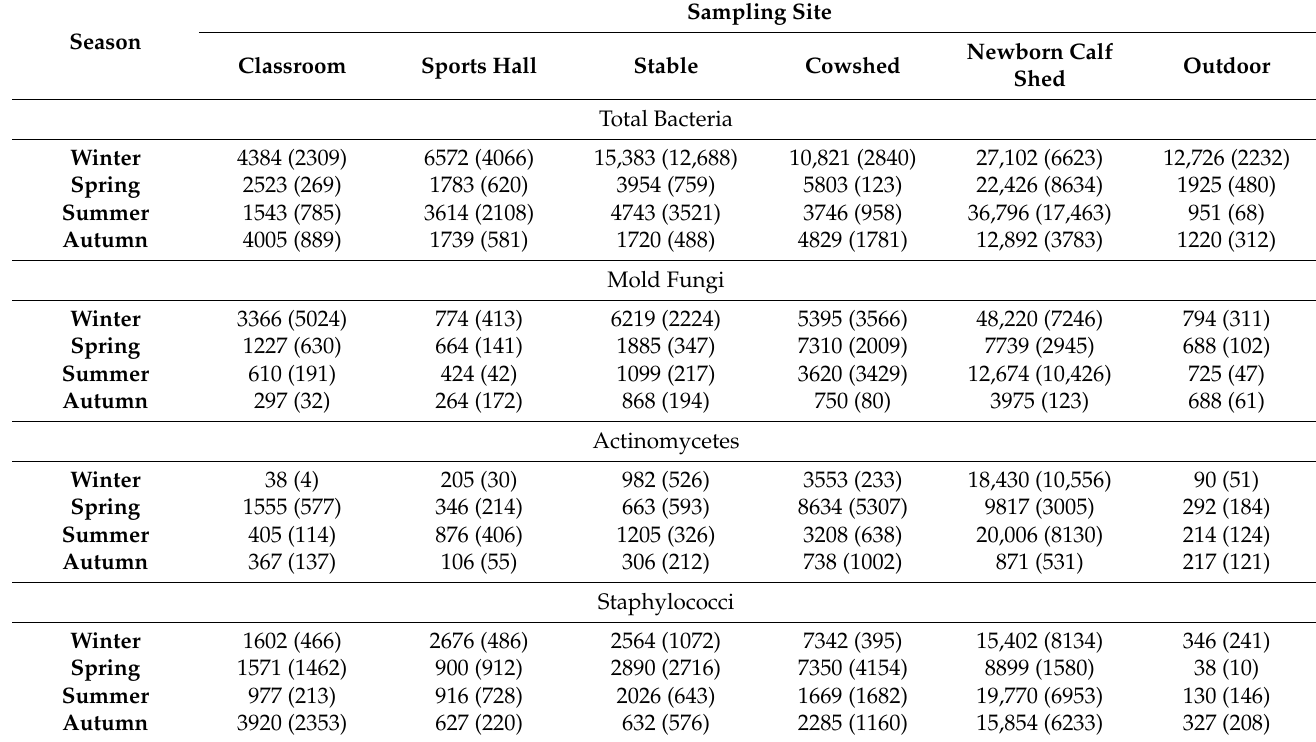
Table 4. Concentration of microbial aerosol components (CFU/m 3 ) in the premises of the agricultural school and in outdoor air. The presented values are means of three replicates. There are standard deviations provided for each season and site in